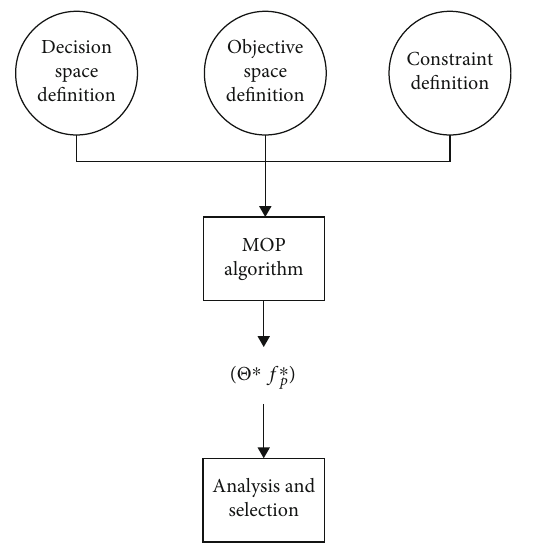
Figure 7: Multiobjective optimization design fl ow